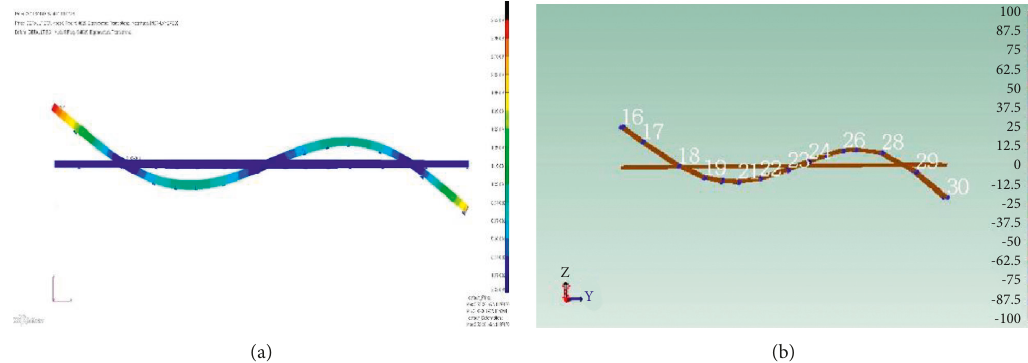
Figure 15: Vertical bending modal shape (3 nodes), design draft loading condition. (a) Numerical prediction. (b) Measurement